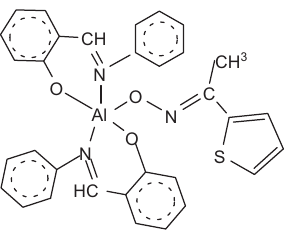
COCHCOCH 3 Al { OC(R) = CH C(R ′ ) = NC 2